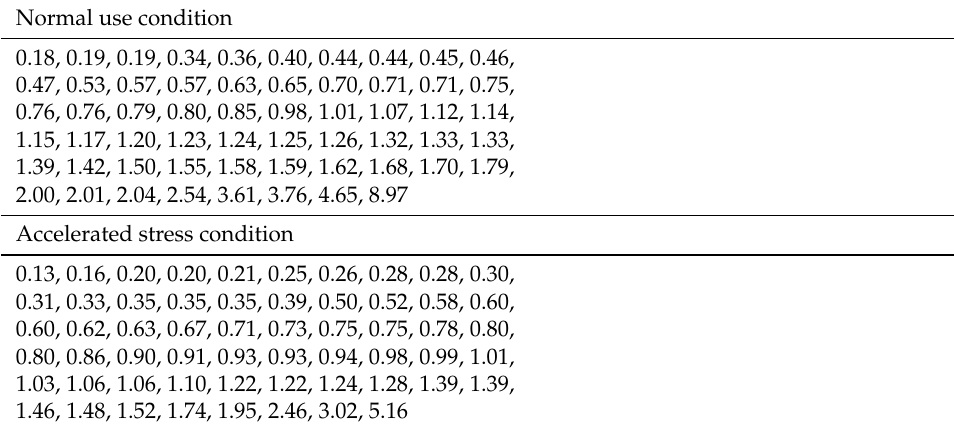
Table 6. Light-emitting diode failure data.